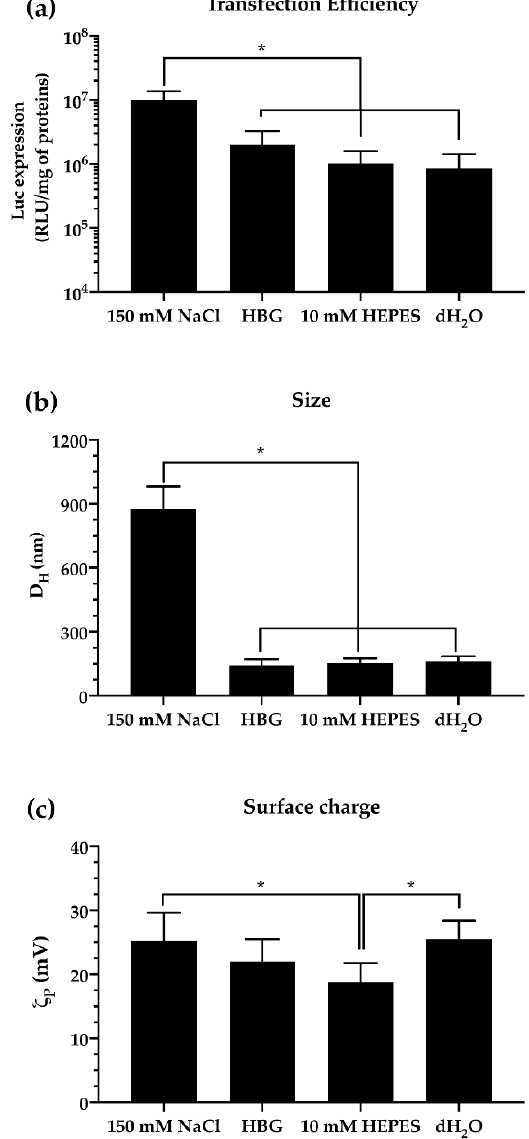
Figure 4. Effect of complexation buffer on the transfection efficiency and physico-chemical features of pDNA/ l PEI polyplexes prepared at N/P 30 in L929 cells. ( a ) Transfection efficiency of pDNA/ l PEI complexes prepared in different buffers. Complexes were prepared by adding 160 ng/cm 2 of pGL3 to the l PEI solution. ( b ) Hydrodynamic diameter (D H ) and ( c ) overall surface charge ( ζ P ) of pDNA/ l PEI complexes prepared by adding 1 µ g of pDNA to the l PEI solution, then complexes were diluted in different buffers. Measurements were carried out by means of a dynamic light scattering (DLS; for D H measurements) and electrophoretic light scarring (ELS; for ζ P measurements) apparatus. Results are expressed as mean ± SD (n ≥ 3) (* p < 0.05).